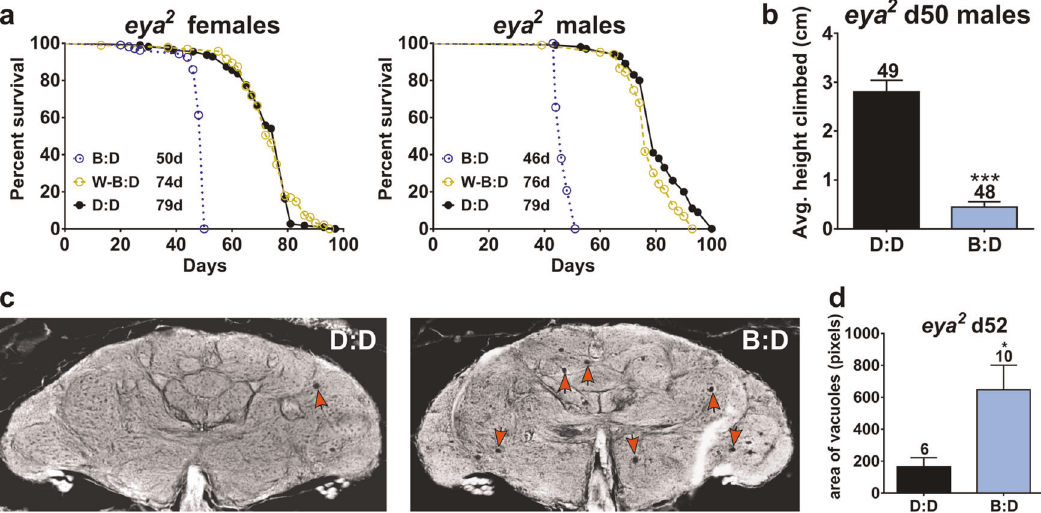
Fig. 5 Flies lacking retina show reduced lifespan and brain neurodegeneration in blue light. a Lifespan of eyes-absent mutant ( eya 2 ) fl ies is signi fi cantly reduced in B:D compared with D:D (Log-rank test, p < 0.0001 for males and females), but is similar in W – B:D conditions ( N = 100 for each light condition). b Aged eya 2 males show a signi fi cant reduction in the average vertical climbing ability in B:D compared with D:D (unpaired t test, p = 0.0009). c Representative brain sections showing brain vacuoles (red arrowheads) in 52-day-old eya 2 males in D:D and B:D. d The average area of brain vacuolization of 52-day-old eya 2 males was signi fi cantly increased in B:D compared with D:D (unpaired t test, p = 0.0352). Numbers above bars indicate the sample size in each light condition. Error bars show